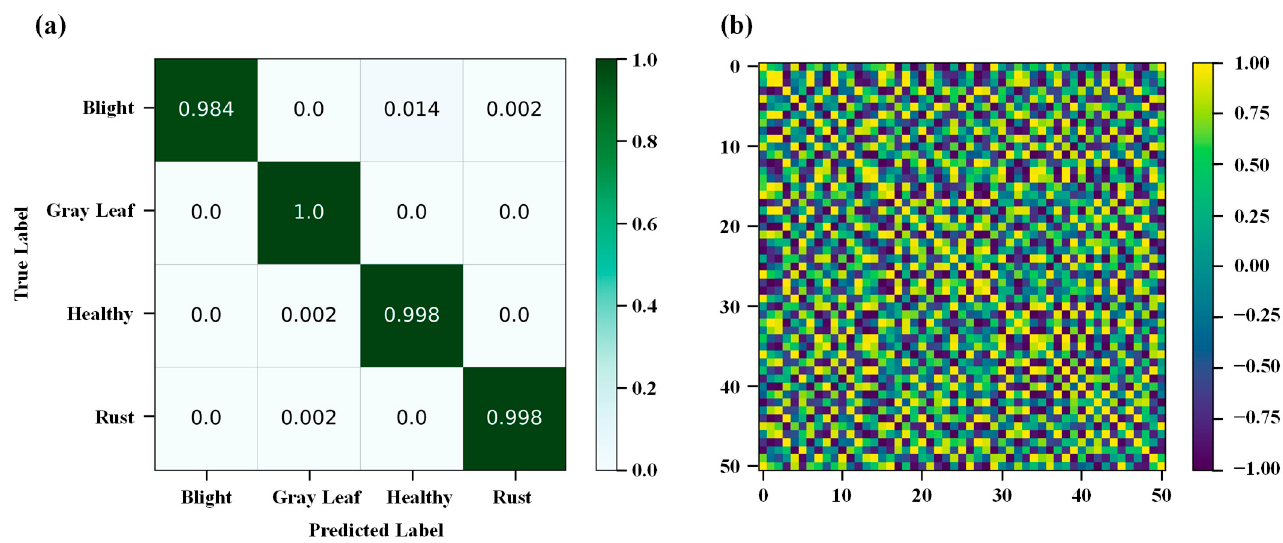
Figure 5. Results of the quantitative analysis. ( a ) Confusion matrix. ( b ) Correlation matrix of 51 ran- domly chosen testing maize samples. 51 randomly chosen testing maize